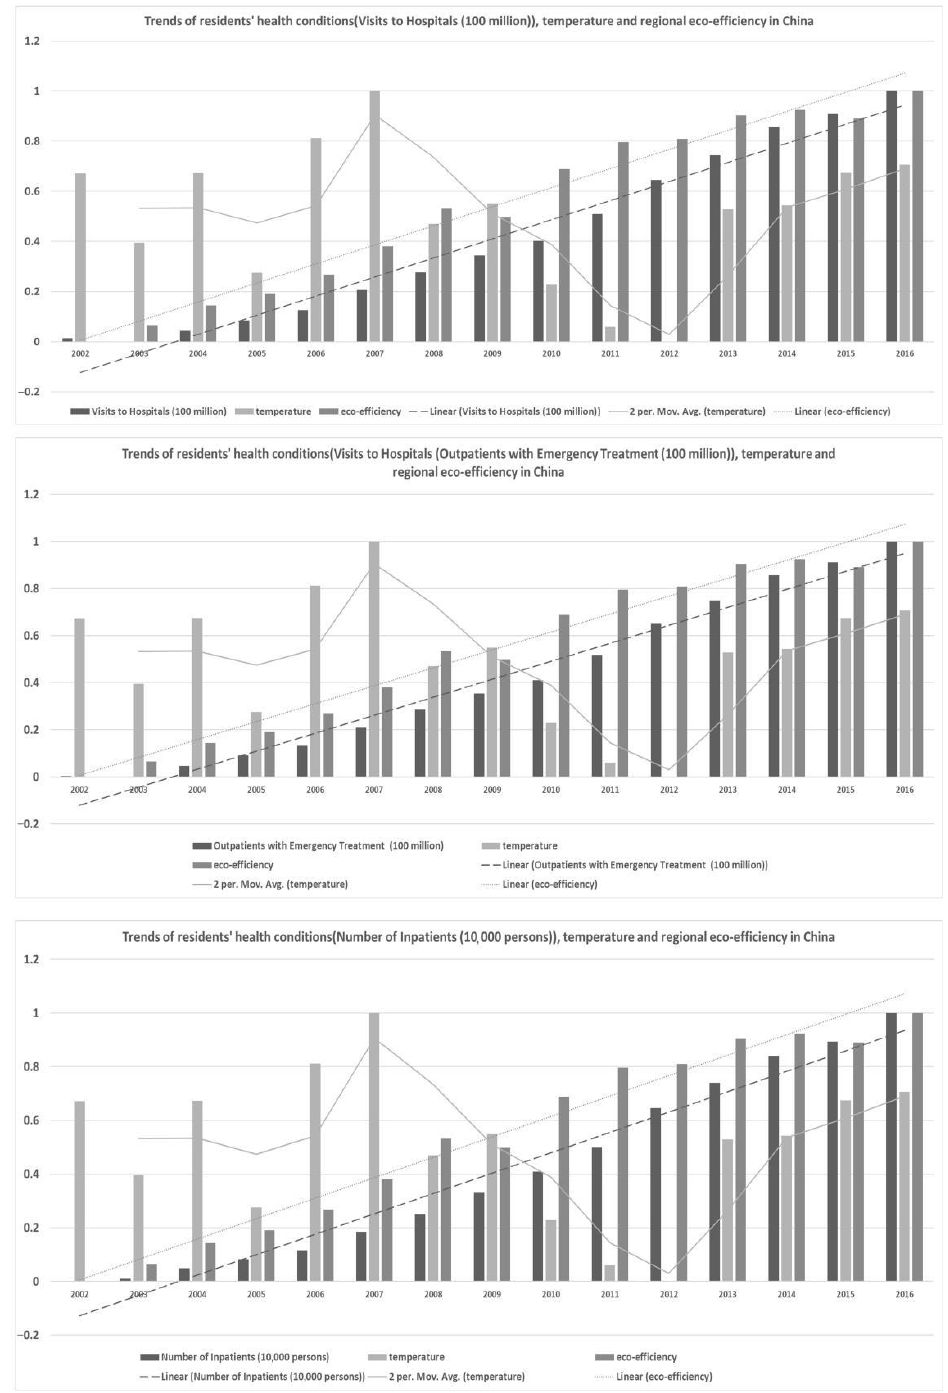
Figure 2. Trends of RHC , temperature, and REE in China.